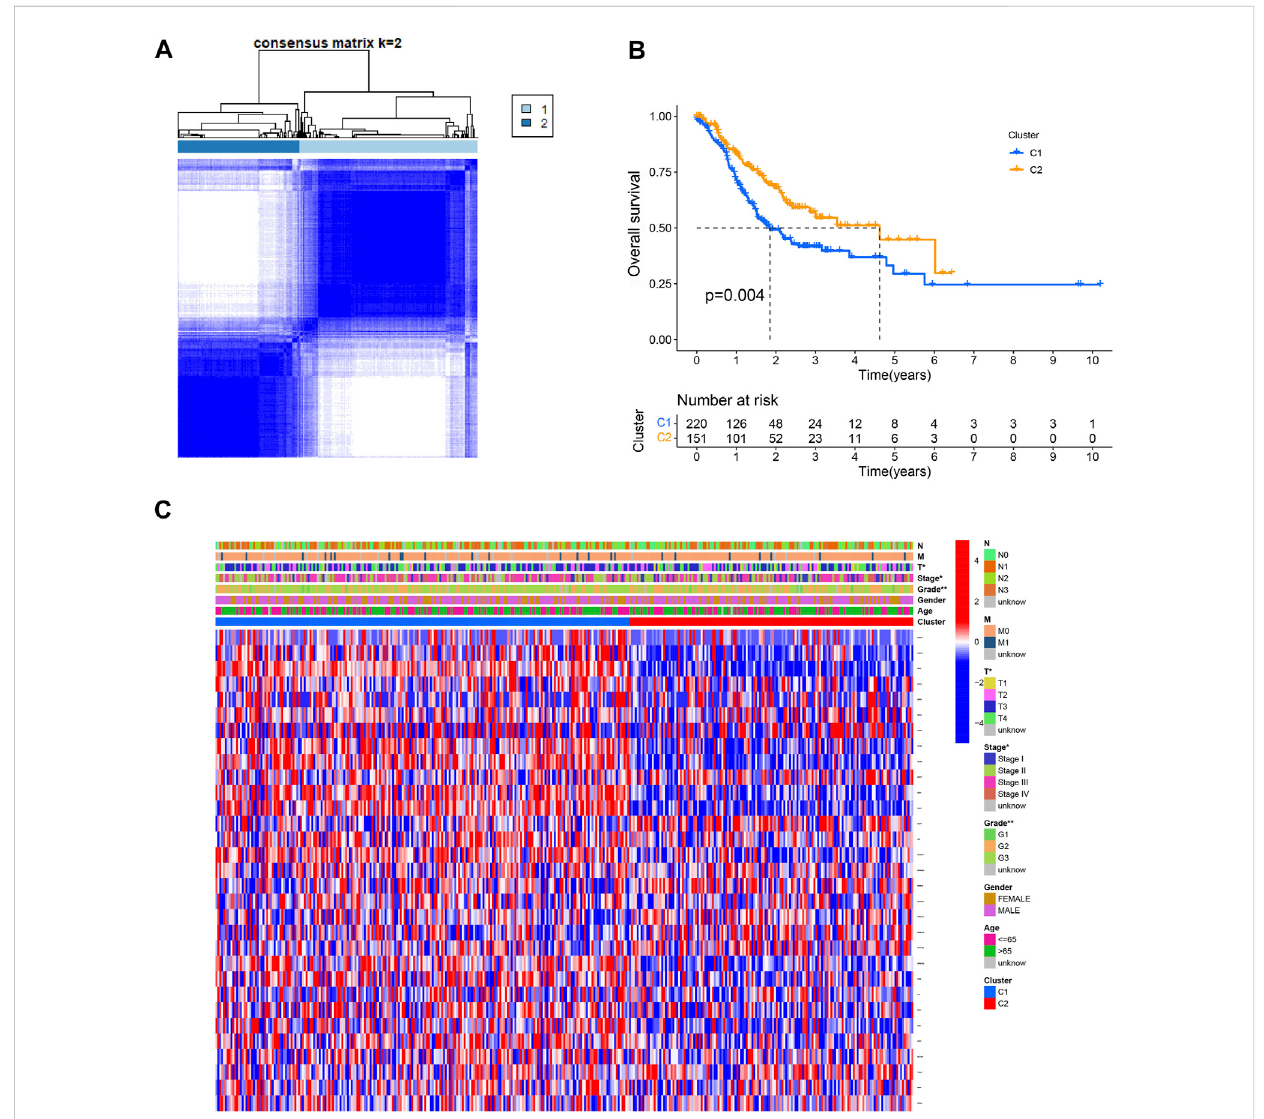
FIGURE 2 Consensus clustering of ROS-related genes in GC. (A) Clustering heatmap for k = 2. (B) K-M curve of C1 and C2. (C) A heatmap for correlation of clusters with clinical